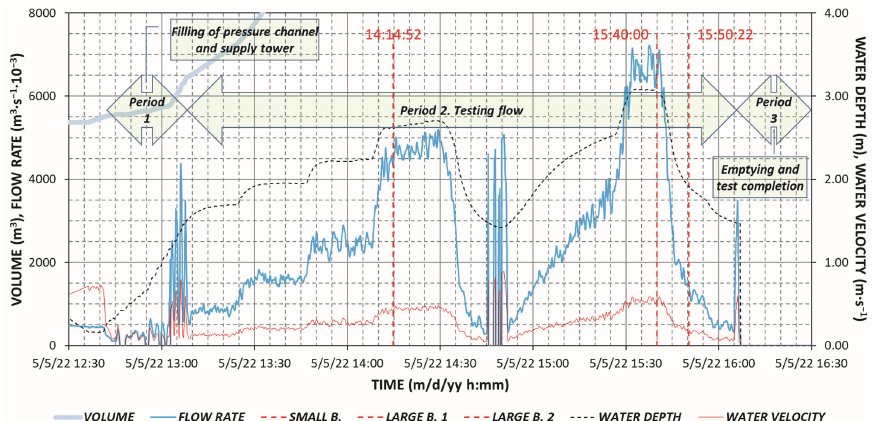
Figure 14. Test Session 2: Inflow hydrograph, water volume, water depth, and flow velocity recorded by the flowmeter in the auxiliary channel.